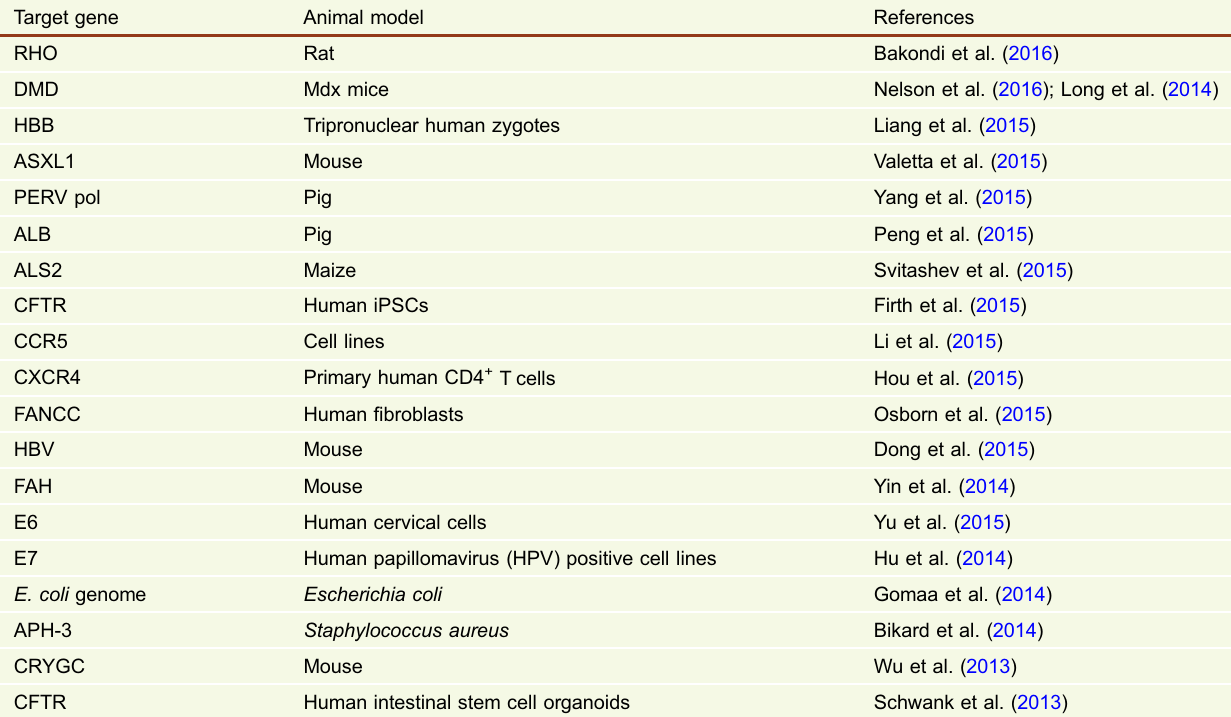
Table 1. A summary of genetic correction using CRISPR/Cas9 technology in cell therapy, agriculture, antimicrobials, and anti-viral treatment from 2013 onwards Target gene Animal